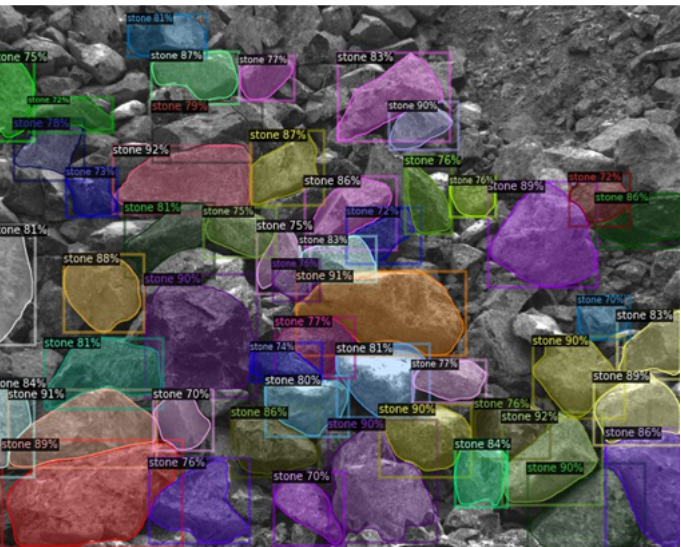
Figure 9. The typical result of the rock chunks in the open pit detection with obtained masks. The result corresponds to the ground truth one in Figure 8.